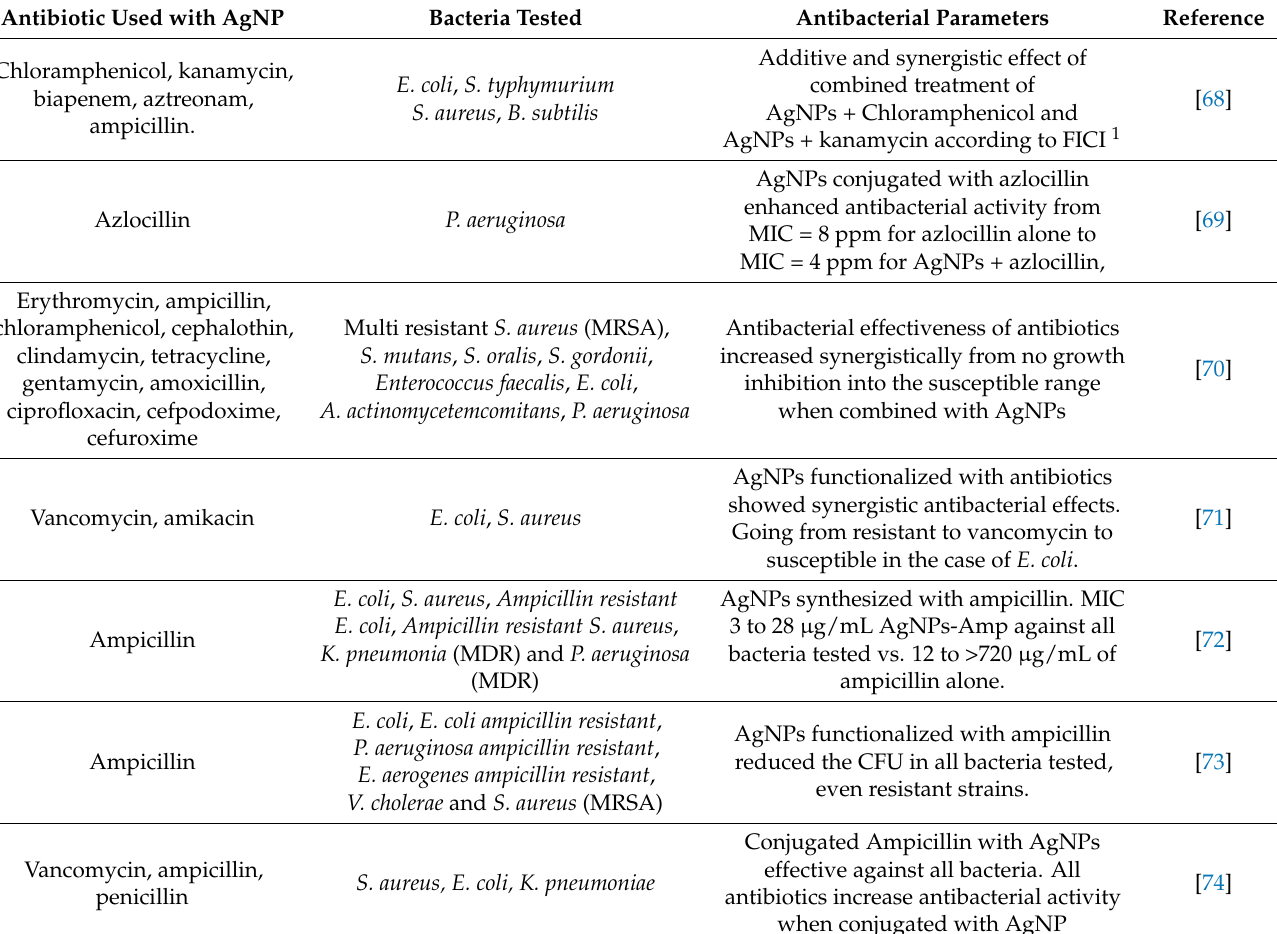
Table 1. Resume of research addressing the use of AgNPs combined with antibiotics. Antibiotic Used with AgNP Bacteria